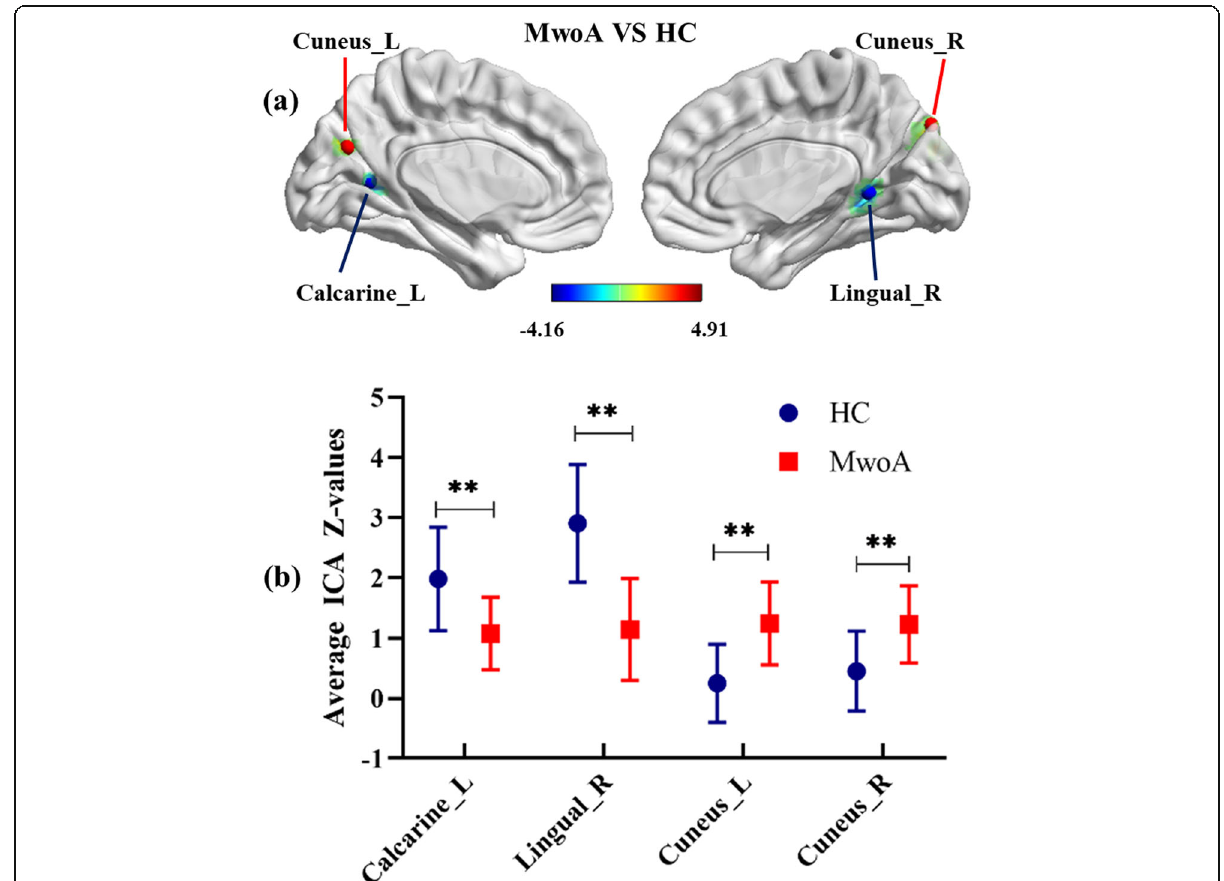
Fig. 2 T-maps of statistically significant differences within the visual network between patients with MwoA and HC ( p < 0.001, uncorrected) ( A ). Comparison of average ICA Z-values in surviving visual areas between patients with MwoA and HC ( B ). ICA: independent component analysis; MwoA: migraine without aura; HC: healthy controls; L: left; R: right; ** p < 0.001